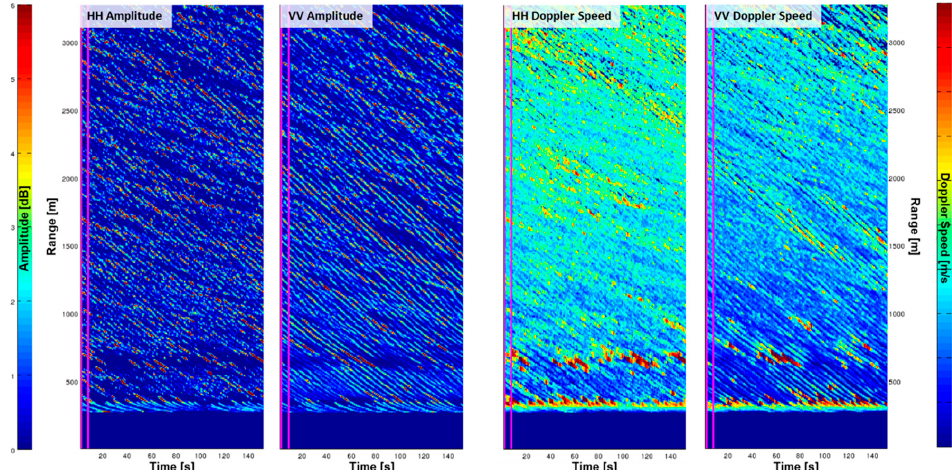
Figure 9. Intensity and Doppler speeds retrieved from the MR with a fixed antenna pointing towards west at the site of Sylt, Germany. The data were collected on the 13 March 2014 with a HH-polarized antenna at 17:00 UTC and VV-polarized antenna at 18:00 UTC using the same radar scanner.